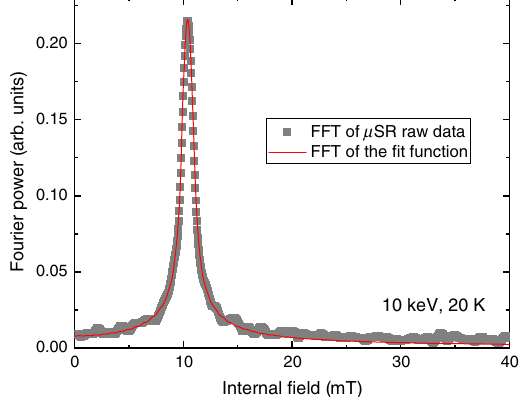
FIG. 12. Averaged FFT power of the μ SR raw data (points) and of fits (solid line) shown in Fig.